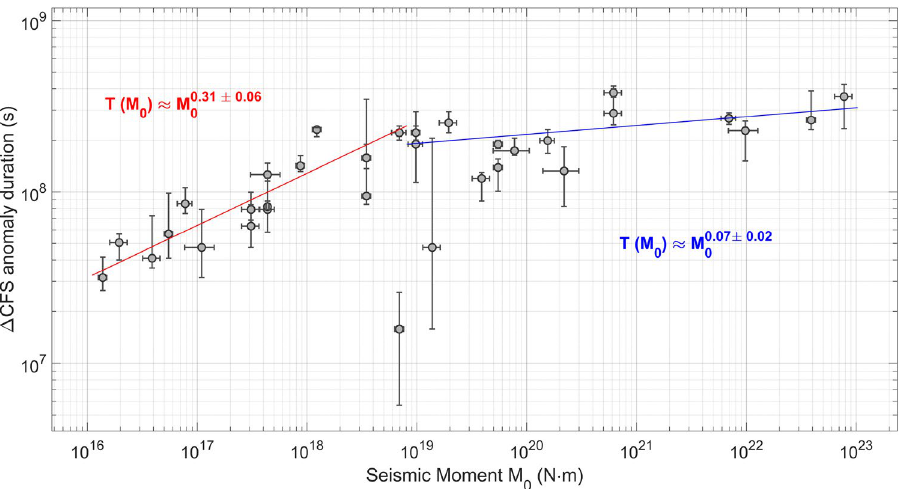
Figure 5. Preparatory phases are observed before thirty-five large and intermediate (M w (cid:31) 4.5 ) shallow (depth ≤ 50 km) earthquakes all over the world. Each measure with error-bar corresponds to a seismic sequence. The duration of the anomalies is empirically related to the seismic moment of the impending mainshock through T ≈ M 0.3 0 for M w (cid:31) 6.5, while the scaling relation becomes T ≈ M 0.1 0 for M w (cid:31) 6.5, according to the best-fits, represented, respectively, by the continuous red and blue lines. Our results support the hypothesis that seismic regions are over-stressed for months up to 15−years−long periods before main failure. However, variability is large, although there is a positive correlation between duration of increasing seismic responsiveness to stress perturbations and magnitude of impending earthquakes. A better estimation of the scaling exponents should be done including additional low magnitude ( (cid:31) 4.5) seismic events. Fit R